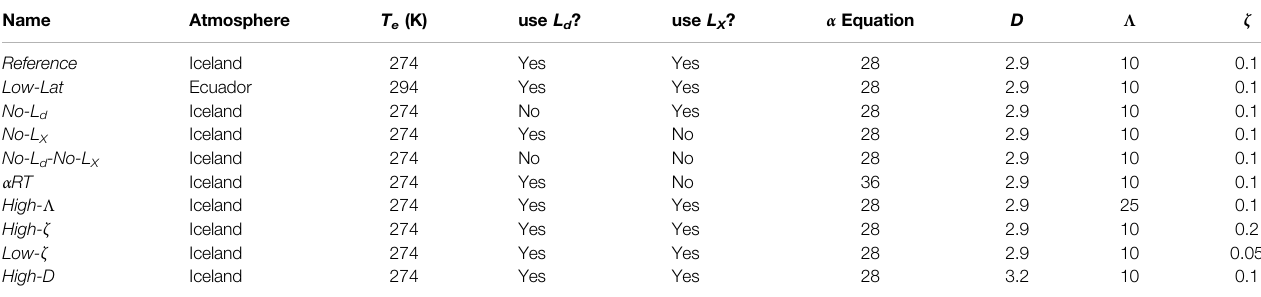
TABLE 2| Listofsimulations setshighlightingvariedmodel parameters: Atmosphericpro fi le,externalwatertemperature T e ,decompression lengthswitch,crossoverlength switch, entrainment equation, PSD power-law exponent D , particle roughness scale Λ , and fragmentation energy ef fi ciency ζ .